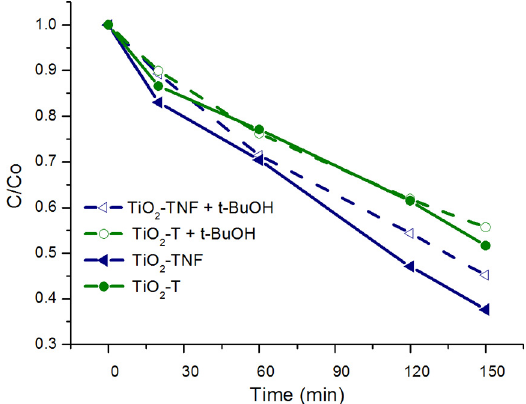
Figure 11. Effect of t-BuOH scavenger on the rate of CN - degradation on TiO -TNF and TiO -T 2 2